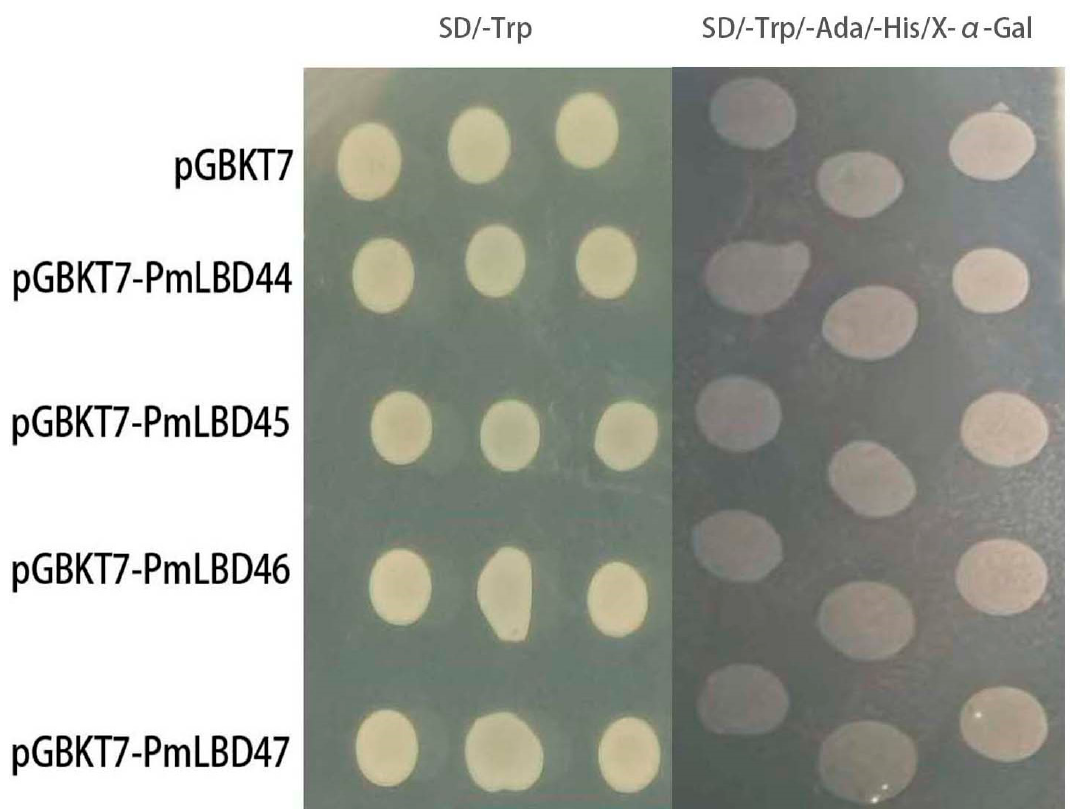
Figure 9. Transcriptional self-activation assay for pGBKT7-PmLBD vector. The negative control pGBKT7 was incubated empty with the decoy vector pGBKT7-PmLBD co-spotted with SD/-Trp and SD/-Trp/-His/-Ada/X- α -gal, and both were found to grow only on SD/-Trp plates.